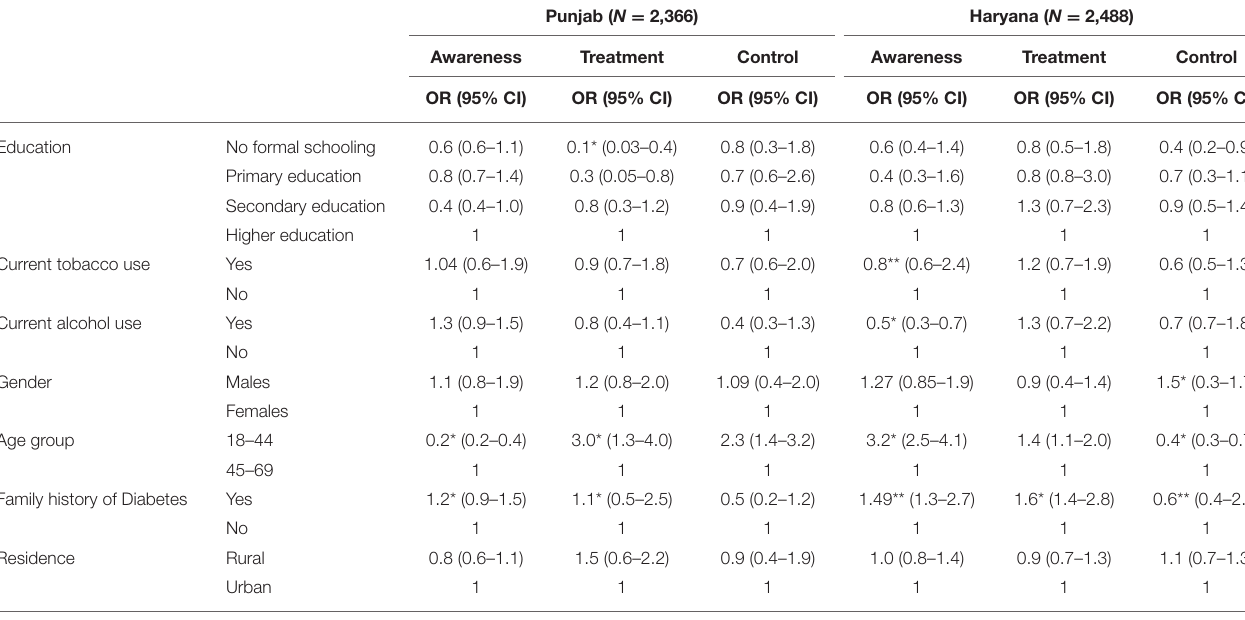
TABLE 5 | Multivariable Logistic Regression Model to assess Factors associated with awareness, treatment, and control of diabetes in Punjab and Haryana, India. Punjab ( N =